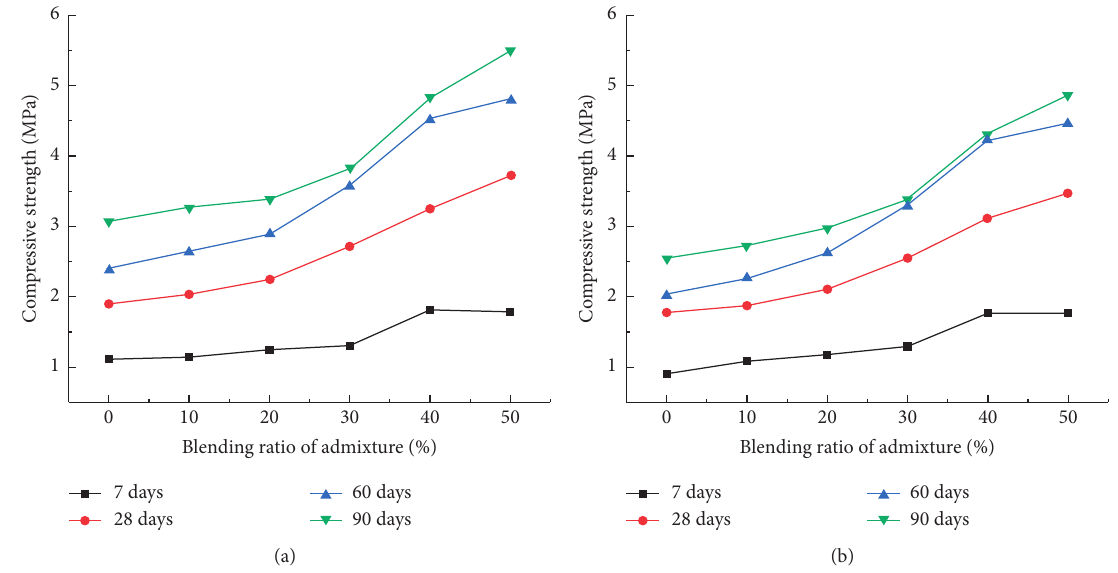
Figure 2: Strength of soil-cement in (a) freshwater environment and (b) marine